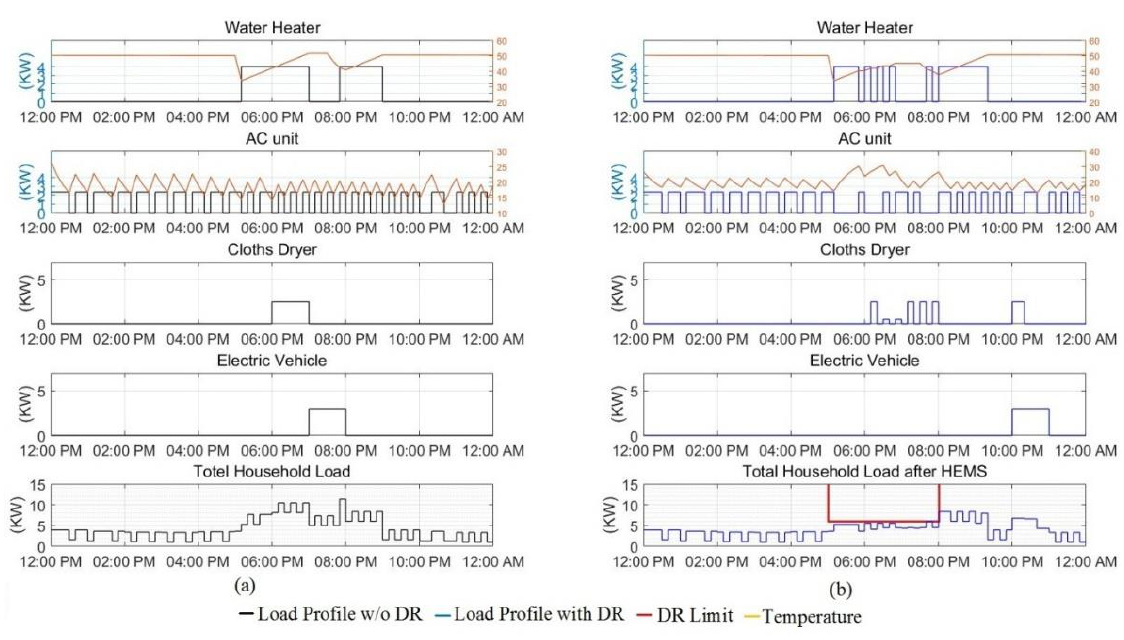
Figure 9. Home load profile for unified HEMS. ( a ) No demand limit; ( b ) 6 KW demand limit.